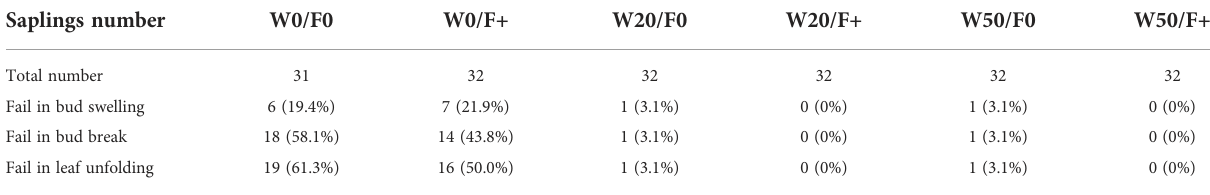
TABLE 1 Number of oaks which failed to reach the phenology stages of bud swelling, bud break and leaf unfolding, under mild (W50), strong (W20) and extreme (W0) drought treatments. Saplings